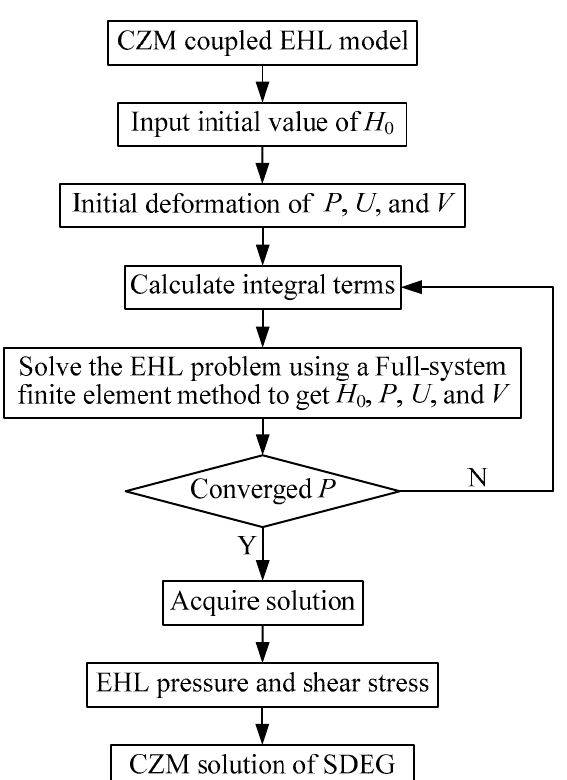
Figure 5. Global numerical solution scheme.